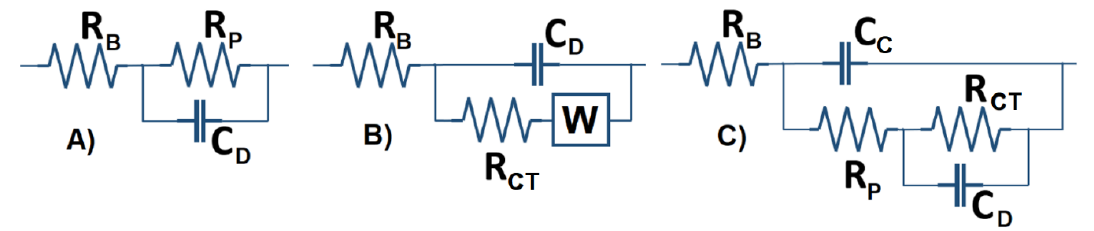
Figure 2. Basic electrochemical electrical equivalent circuit models. ( A ) Modified Kelvin–Voigt (also known as simplified Randles Model) ( B ) Randles model and ( C ) linear approximation of the Randles Model using passive components [20]. Reproduced with permission. © Copyright 1990–2016 Gamry Instruments, Inc.